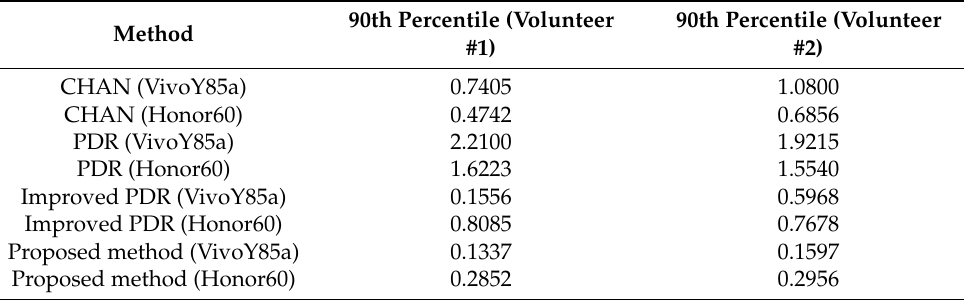
Table 5. The CDF of localization error with Honor60, VivoY85a, and two different height pedestrians in the first scene (m).